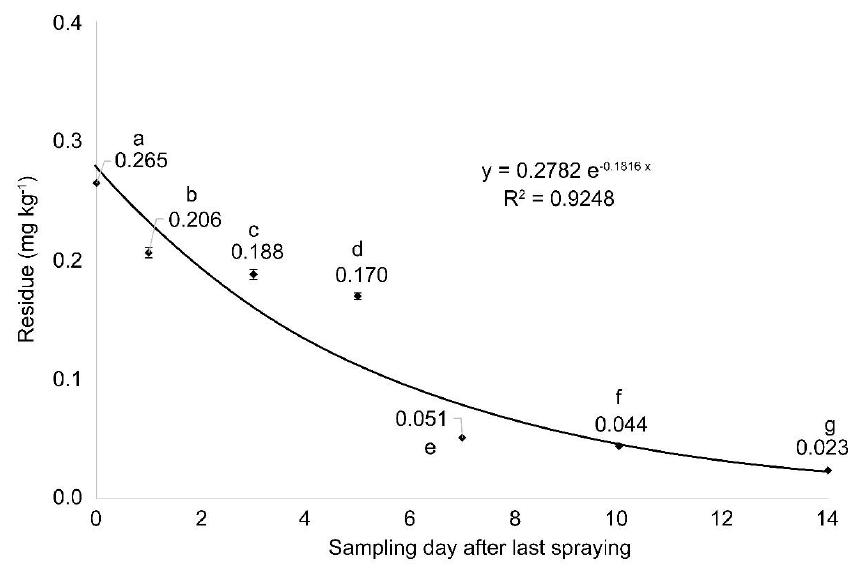
Figure 2 . Average residual concentration with standard deviation (n = 3) of picarbutrazox sprayed using a multicopter on Chinese cabbage throughout the sampling period in plot 2. Different letters indicate significant difference at p < 0.05 by least significant deviation.